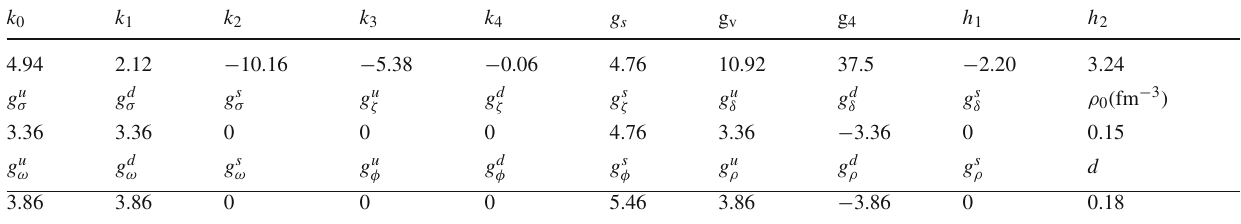
Table 2 Parameters for PCQMF model used in the present